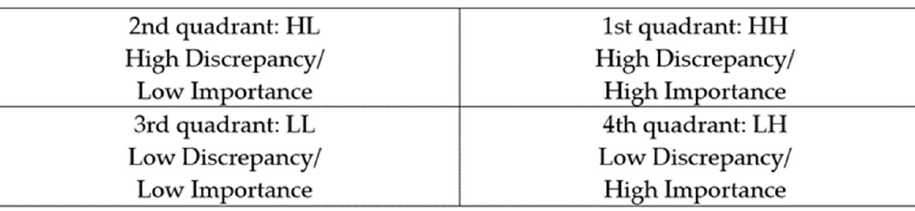
Figure 2. The locus for focus model.